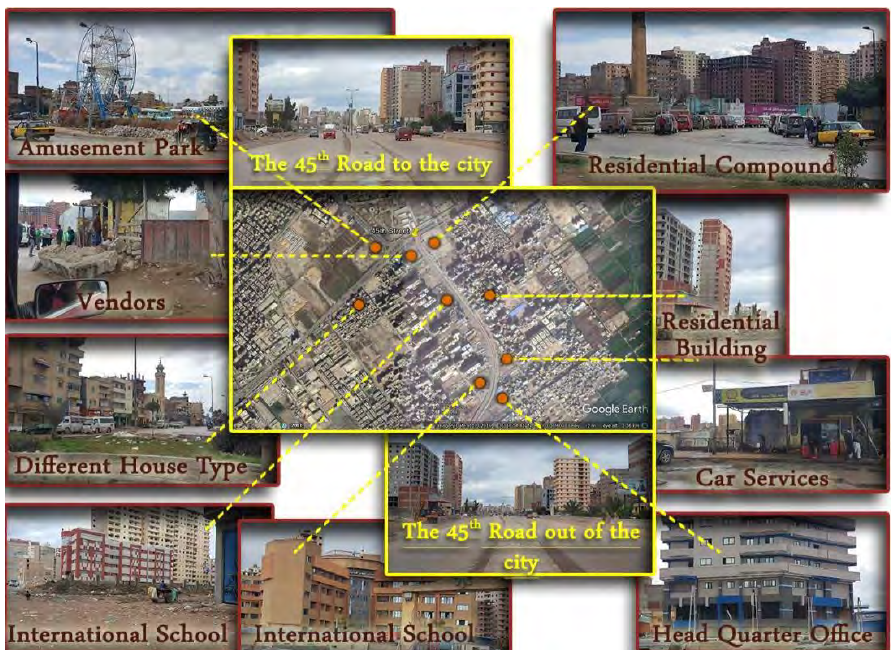
Figure 4. The urban image at the 45th Road (Yoseph, 2017)